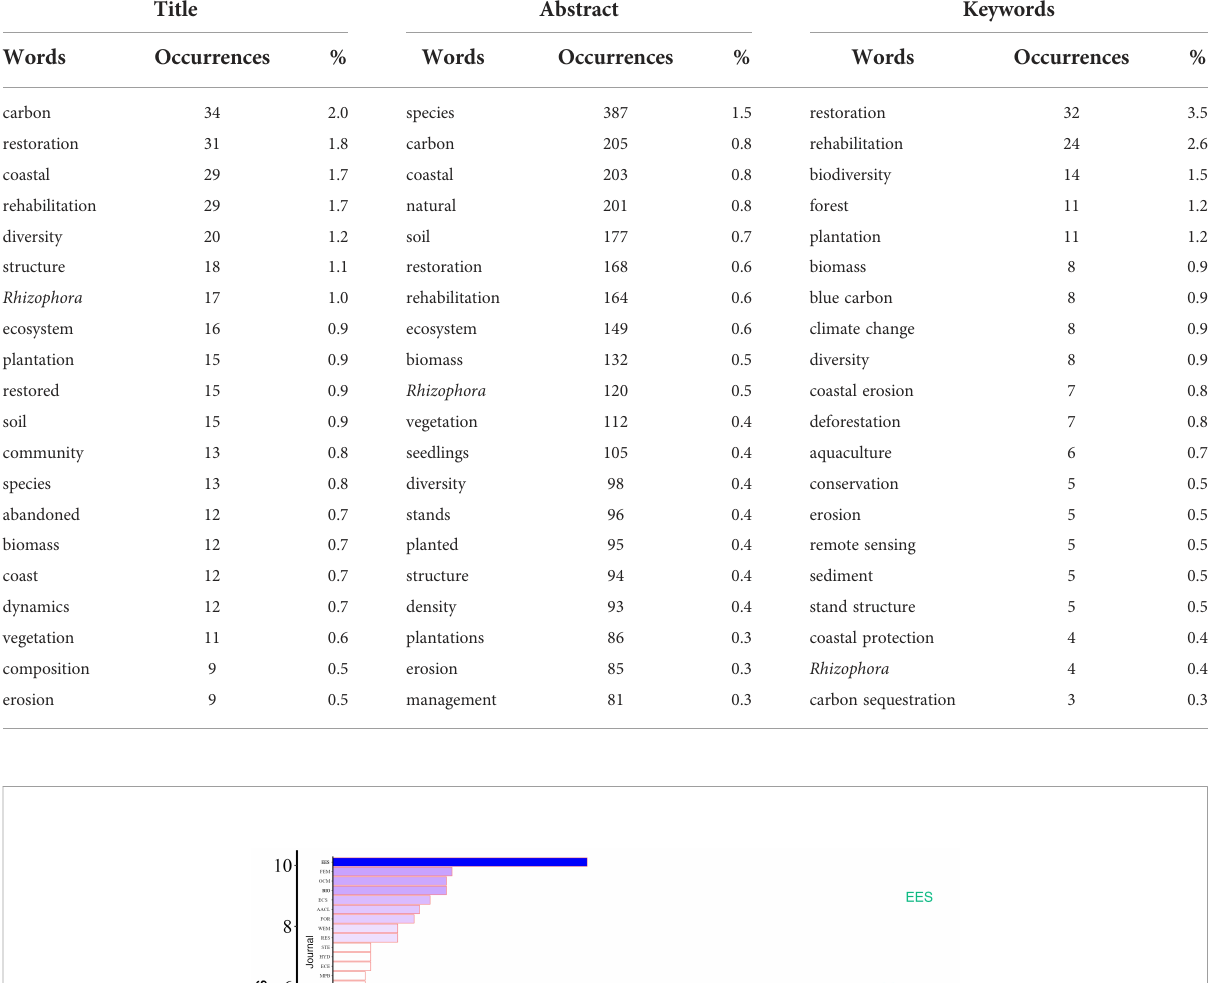
TABLE 1 Most frequent words used in titles, abstracts, and keywords on mangrove studies with ecological attributes in SE Asia.